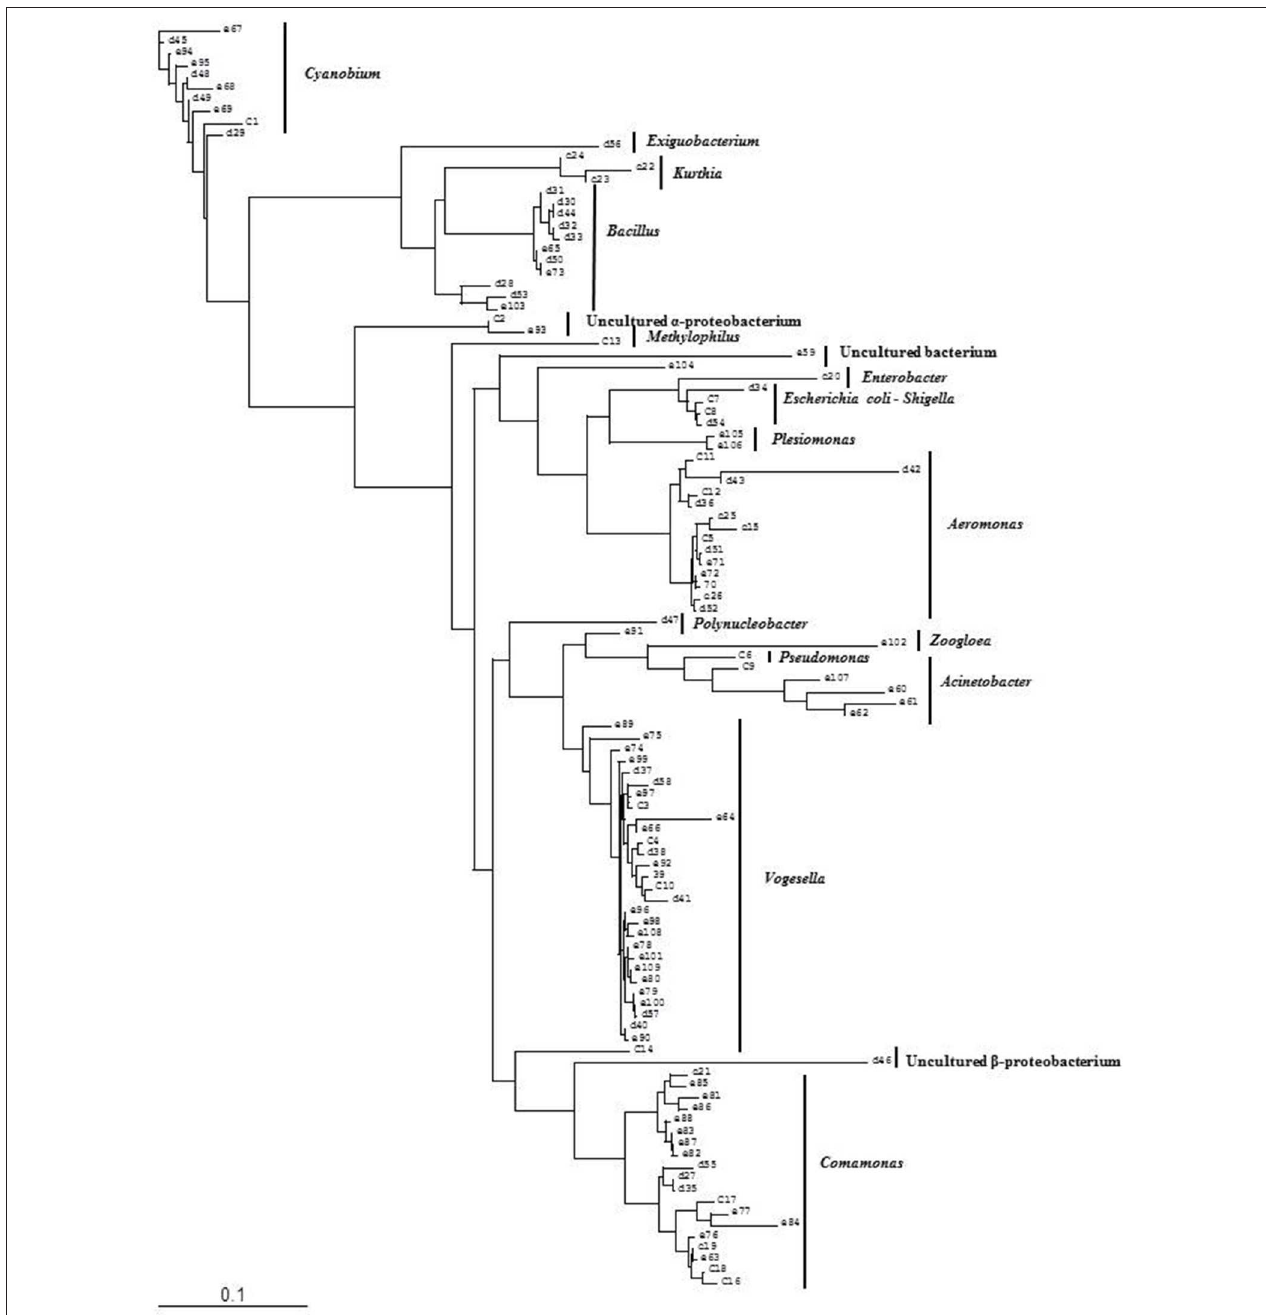
FIGURE 4 | Phylogenetic diversity of bacterial community in Lake Dhanmondi, Dhaka site I based on DGGE (2008–2009). The tree has been rooted with Cyanobium